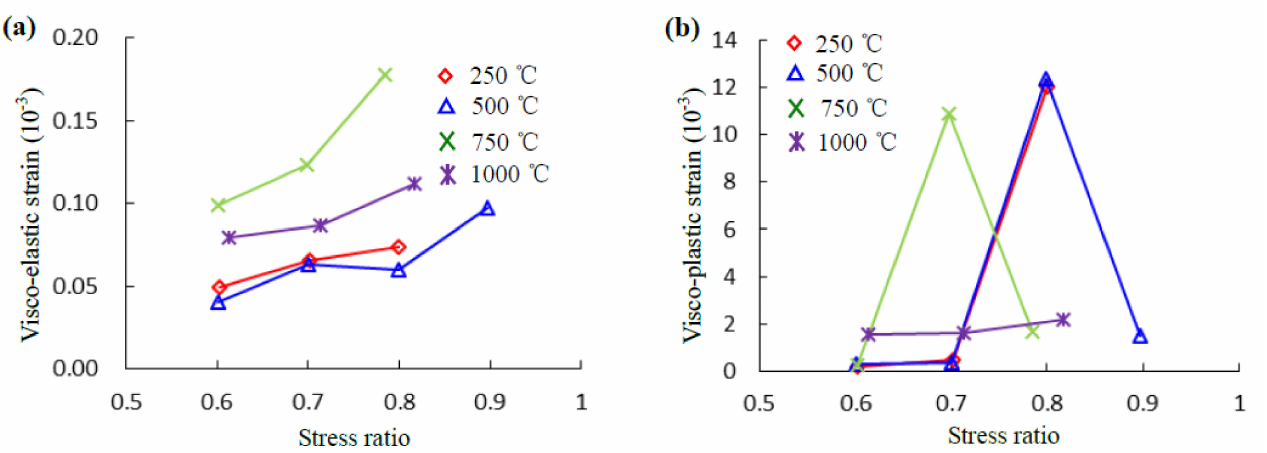
Figure 10. Relationships between stress ratio with visco-elastic strain and visco-plastic strain after different temperature treatment. ( a ) Visco-elastic strain; ( b ) visco-plastic